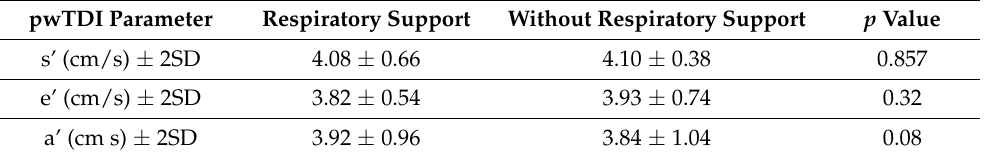
Table 3. Mean values of echocardiographic parameters obtained using the pwTDI technique in ne- onates on respiratory support and without respiratory support.